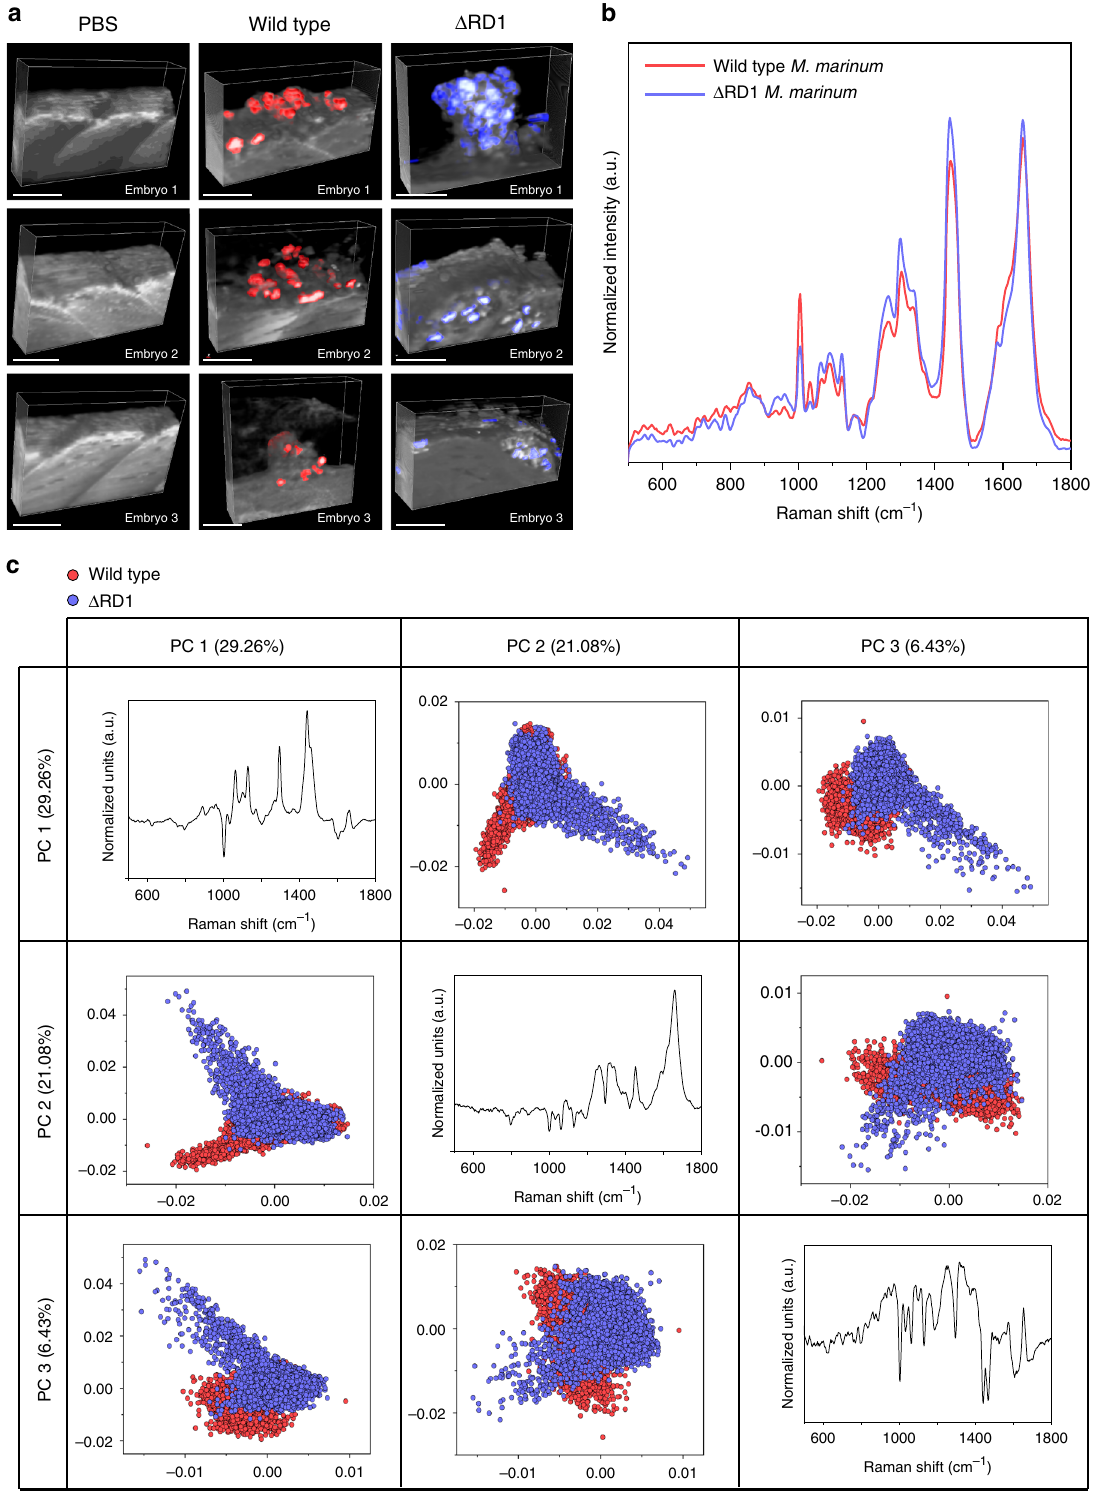
Fig. 5 Biomolecular pro fi ling and discrimination of mycobacterial infections. a Volumetric confocal Raman spectroscopic imaging (cRSI) of zebra fi sh embryos infected with either wild type or Δ RD1 M. marinum or injected with PBS as a negative control. cRSI was performed at 4 days post injection, and 3D reconstructions show embryo tissue in gray with mycobacterial clusters displayed in red (wild type) or blue ( Δ RD1). Scale bars: 50 µ m. b Mean spectra of the mycobacterial clusters extracted from the volumetric cRSI scans for wild type M. marinum (red trace) and the Δ RD1 mutant bacteria (blue trace). c Principal component analysis showed clear separation of the wild type M. marinum (red markers) and the Δ RD1 mutant bacteria (blue markers) using the three principal components (PC1, PC2,